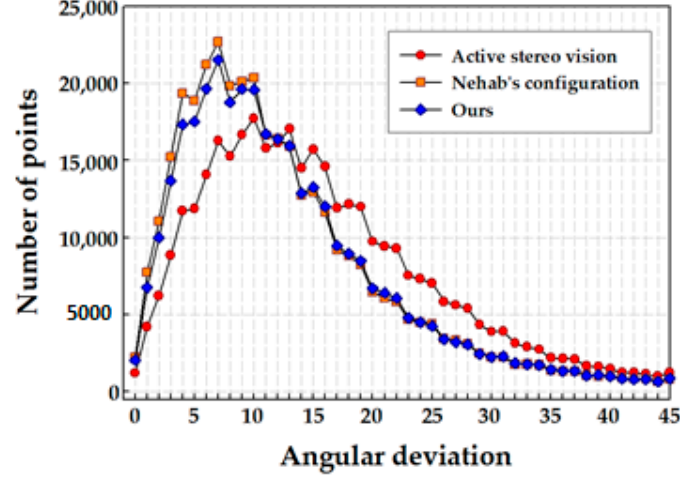
Figure 12. Angular deviation of the normal vector.